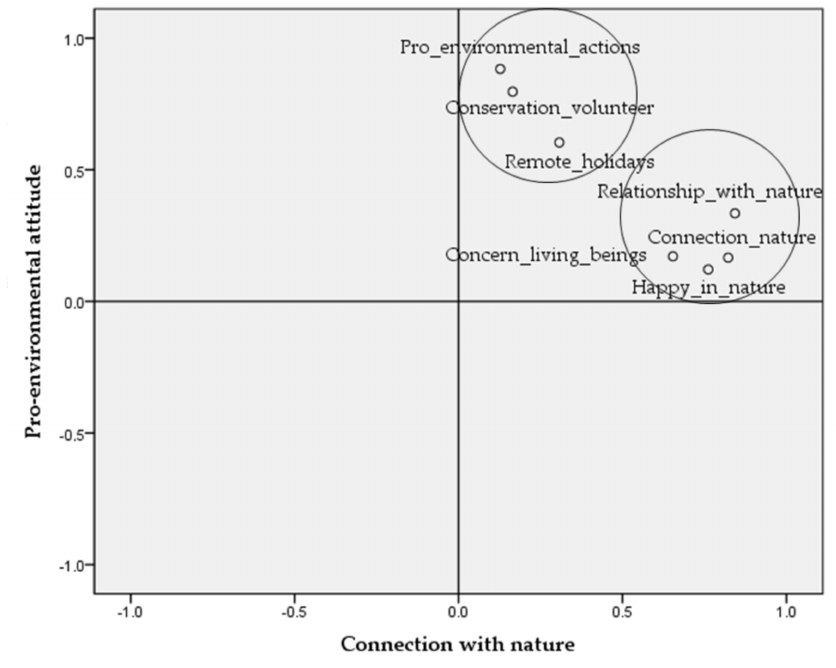
Figure 2. Rotated components.